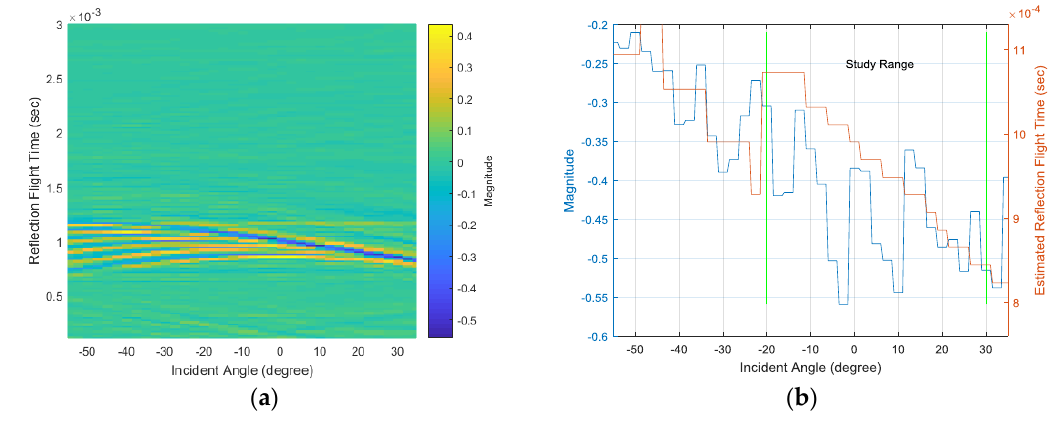
Figure 13. ( a ) SRIR experiment results for various angles at a 2.5° step and ( b ) the minimum magnitude (left y-axis) and RFT (right y-axis).